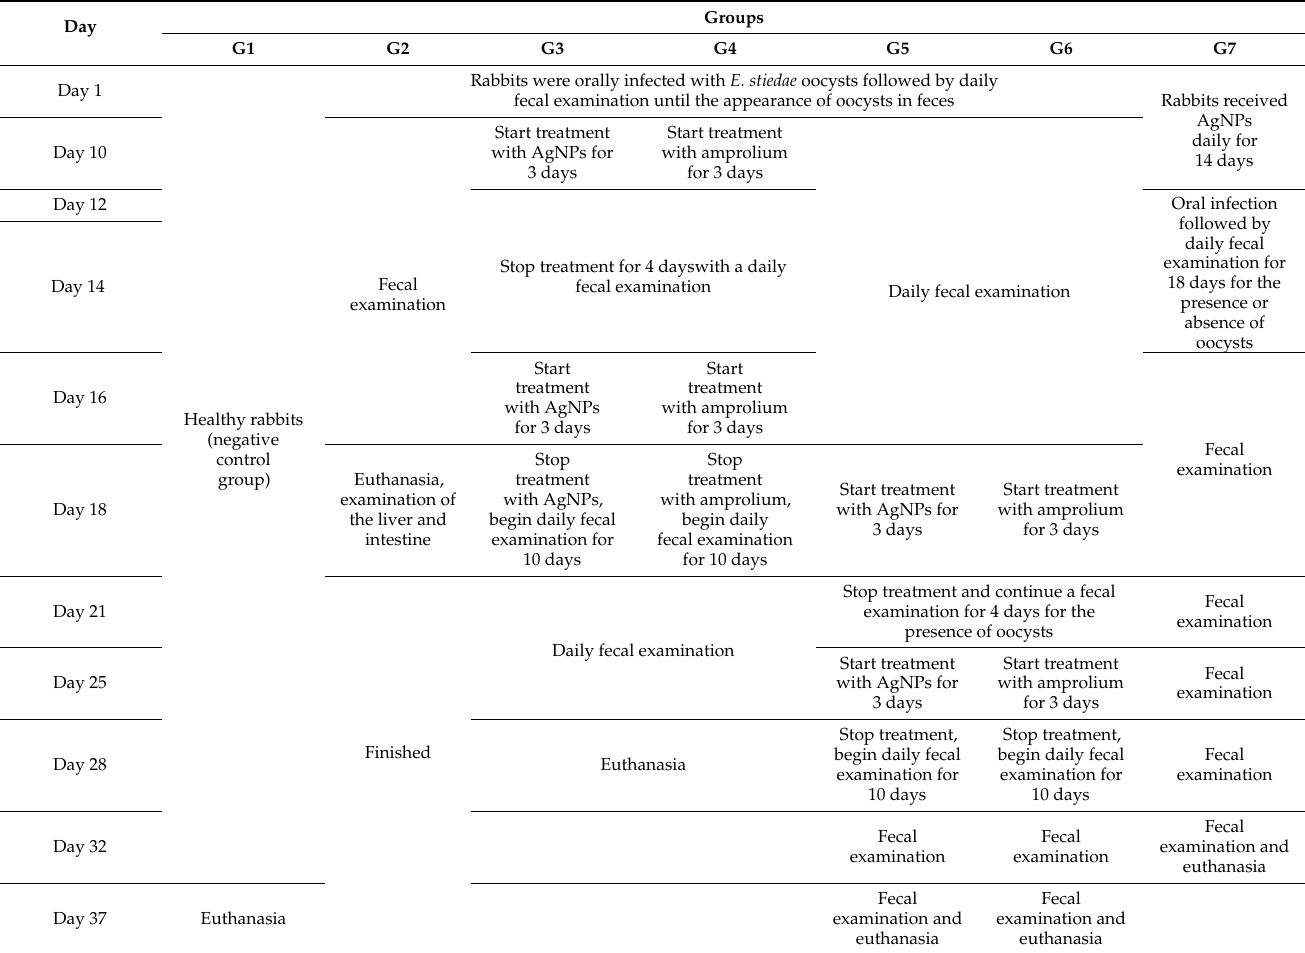
Table 1. The design of the experimental